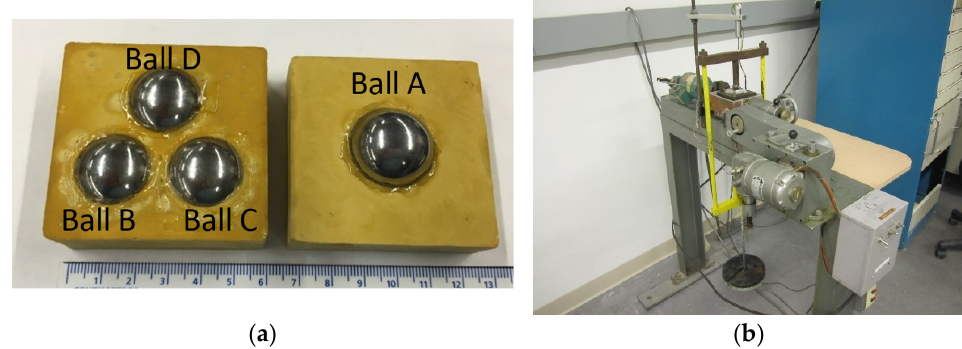
Figure 1. ( a ) The embedded steel balls in the sulfaset paste plate for interparticle friction measurement. ( b ) The direct shear apparatus used for interparticle friction measurement.